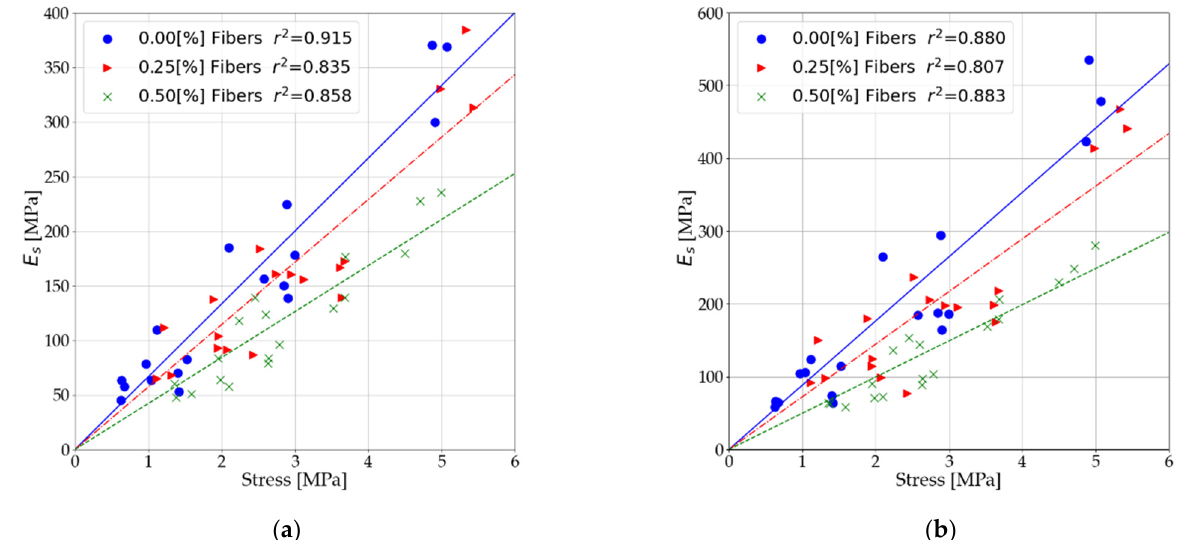
Figure 11. Influence of fibers on the relationship of secant moduli and ultimate compressive strength ( a ) before interpretation of measurement data and ( b ) after interpretation of measurement data.